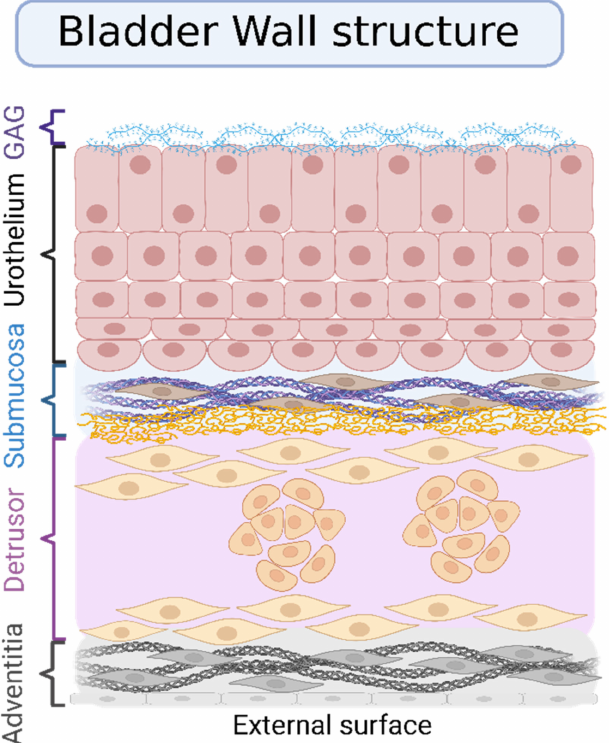
Figure 3. Layers that compose the bladder wall. The inner layer is called the urothelium, and its luminal surface is covered with glycosaminoglycan (GAG). The urothelium is composed of three sublayers. The first one is made of basal cells attached to a basement membrane; the superficial layers, i.e., the second and the third ones, are made of large hexagonal cells, the umbrella cells. Under the urothelium, the submucosa or lamina propria is composed of fibril-shaped or bundle-shaped collagens (type I and III), an elastin fibrous network, interstitial cells, fibroblasts, adipocytes, afferent and efferent endings, and blood vessels. Lastly, the outer layer is the muscular one (detrusor) covered by the adventitia. Created with BioRender.com, adapted from open access Wang et al., Pharmaceutics; published by MDPI, 2021